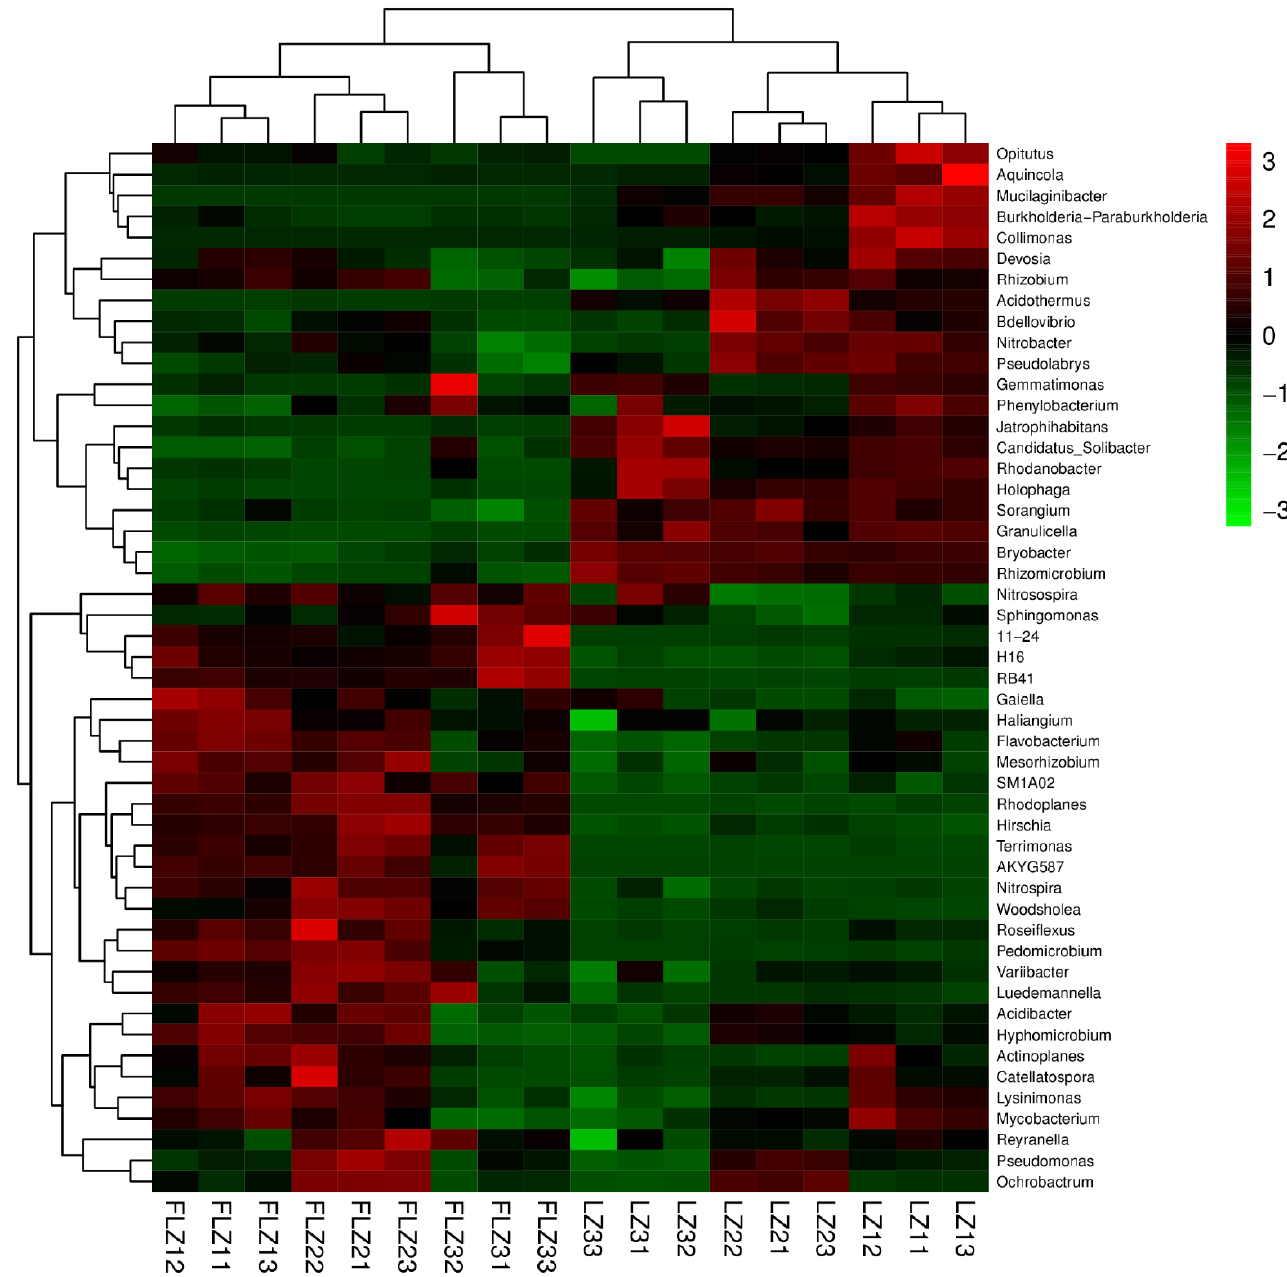
Figure 4. Heat map analysis of the top 50 most abundant genera in six different treatments. LZ1, FLZ, LZ2, FLZ2, LZ3 and FLZ3 represent the soil samples collected from continuous cropping (LZ) and main cropping (FLZ) at the 4 May (LZ1 and FLZ1), 14 July (LZ2 and FLZ2) and 19 September (LZ3 and FLZ3), 2016.